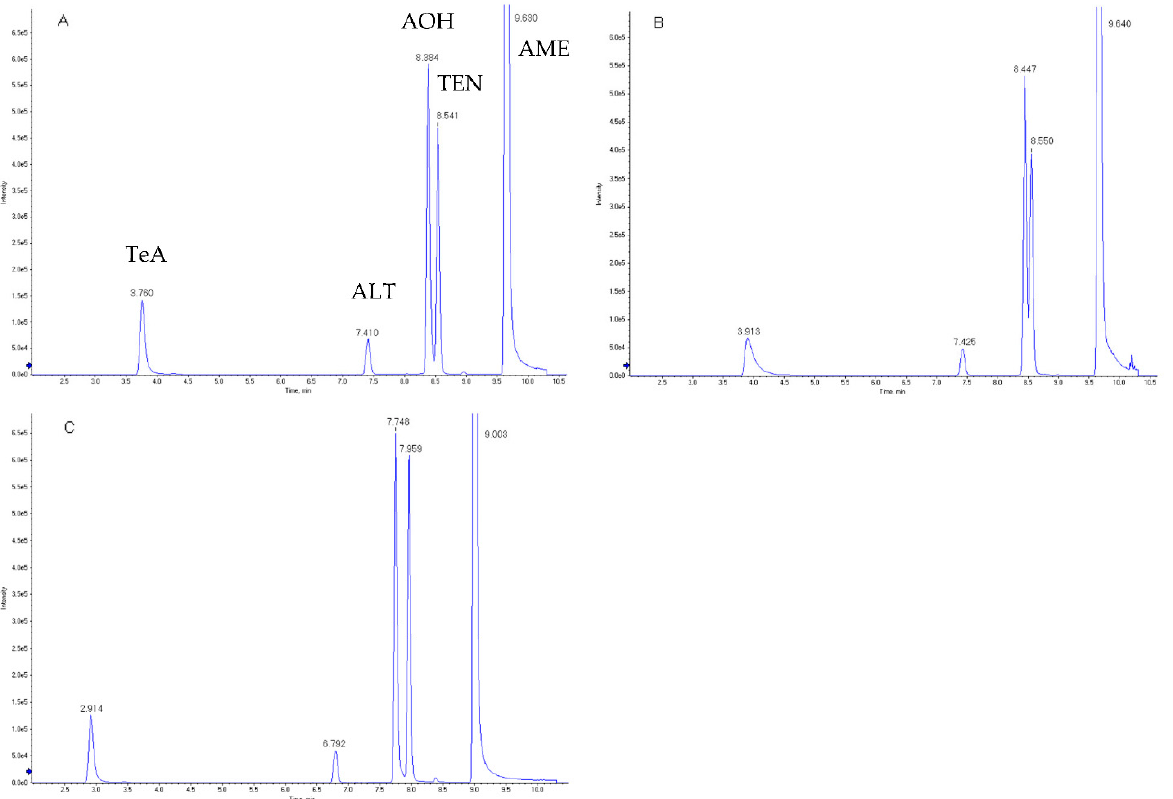
Table 3. Chromatographic parameters obtained on the separation of Alternaria toxins using the three most suitable columns (attached with a pre-column).